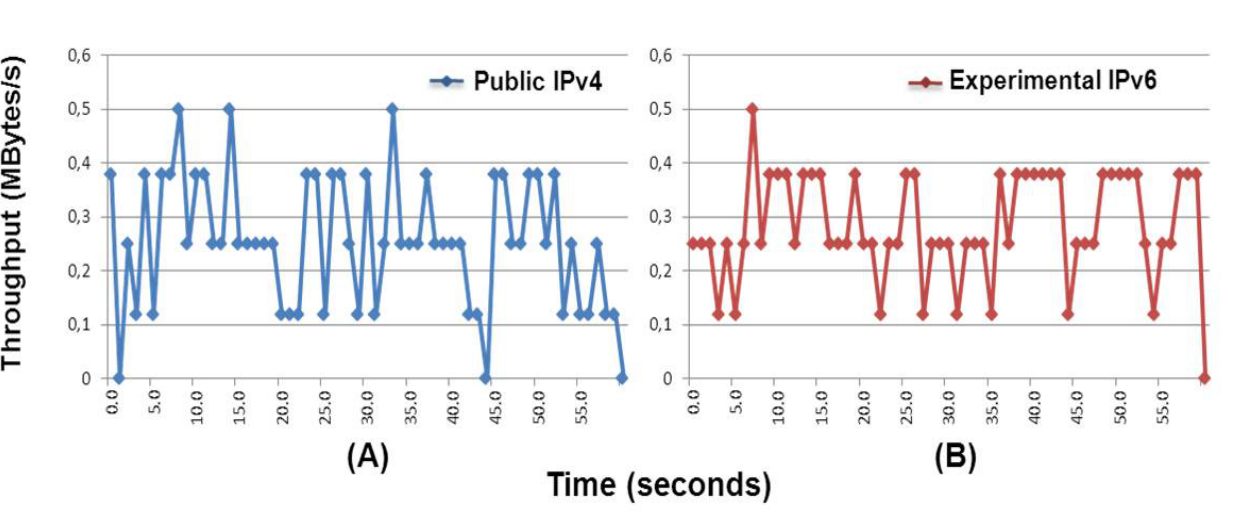
Figure 12. Throughput comparison (testbed conditions) on the mobile router using public IPv4 and experimental IPv6 high-speed downlink packet access (HSDPA) (3G+) APN. Both deployments provided by Orange